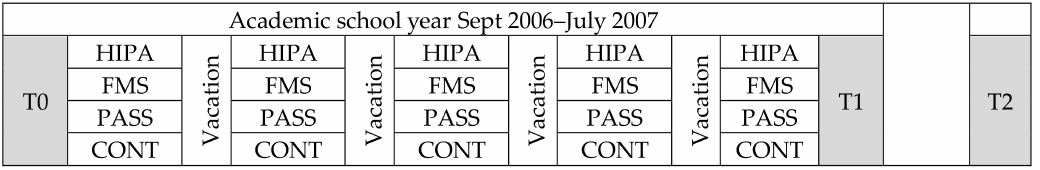
Figure 1. A-CLASS intervention design. Note: HIPA refers to High Intensity Physical Activity intervention; FMS refers to Fundamental Movement Skill intervention; PASS refers to Physical Activity Signposting Scheme intervention, CONT refers to the Control. T0 = baseline data collection (September 2006–mid-October 2006); T1 = 9 months post-intervention follow-up (June–mid-July 2007); T2 = 3 year follow-up (October